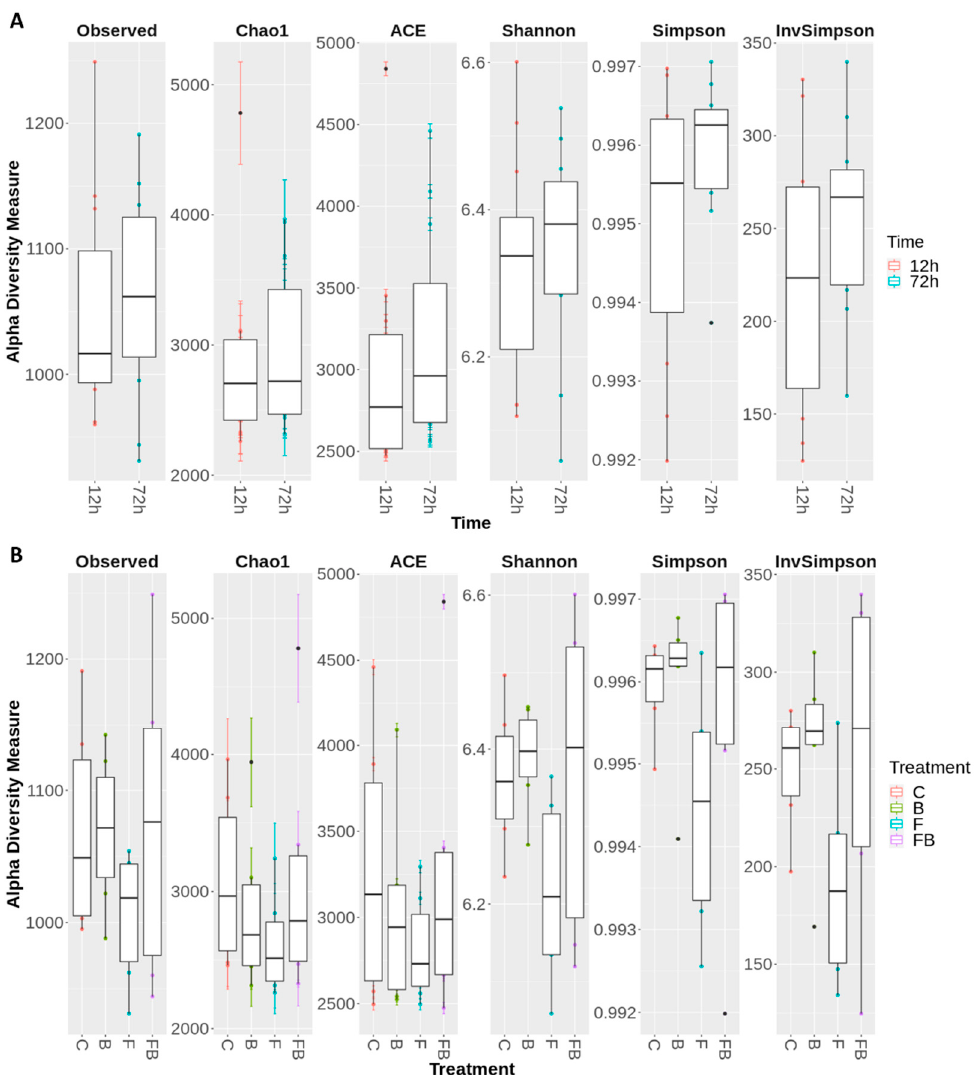
Figure 3. Boxplot demonstrating the range and the distribution of the of OTUs, evaluated using the α -diversity indices observed richness, Chao1, ACE, Shannon, Simpson, and InvSimpson, ( A ) 12 and 72 h after inoculation with Fusarium oxysporum f. sp. radicis-lycopersici ; ( B ) for the treatments for the treatments control (C), biosolid − enriched treatment (B), Forl inoculation (F), and Forl inoculation with biosolid application (FB). Values represent the pooled mean of three replicates.